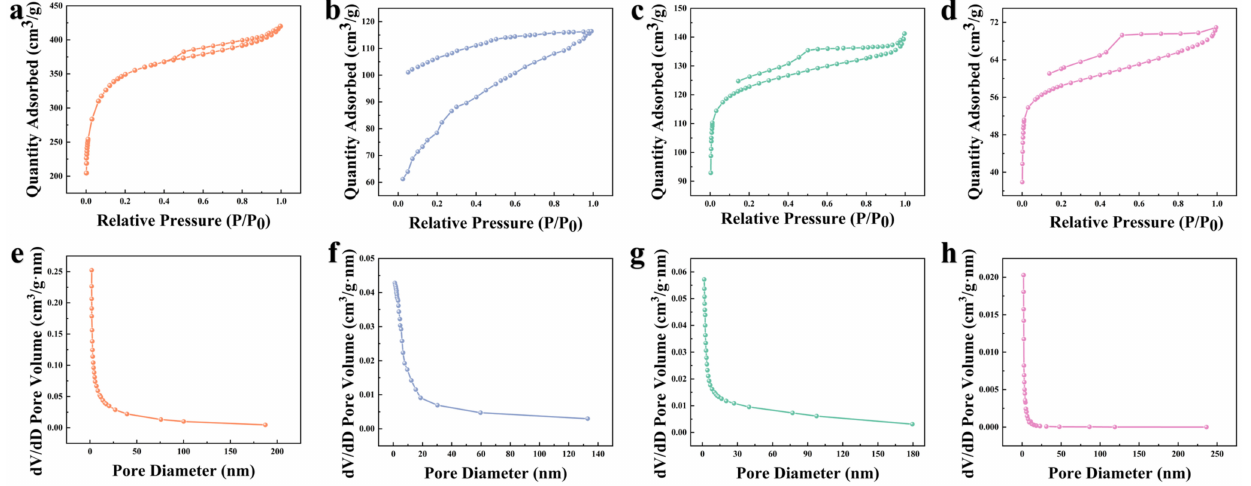
Figure 1. N 2 adsorption–desorption isotherms and pore size distribution of the samples (( a , e ) are K − CSB; ( b , f ) are P − CSB; ( c , g ) are M − CSB; and ( d , h ) are 800 −